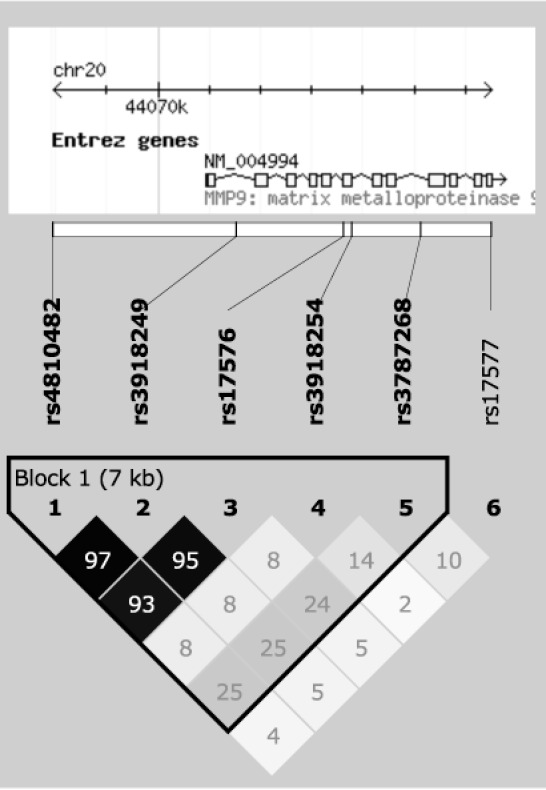
Linkage disequilibrium plot of the 6 tag SNPs around MMP9 in the Chinese dataset of this study.The numbers in the diamond indicate r2; black represented r2 = 1, shades of grey indicated 0< r2 <1, and white referred to r2 = 0. Chromosomal positions were based on NCBI build 36.3 (National Center for Biotechnology Information, Bethesda, MD).